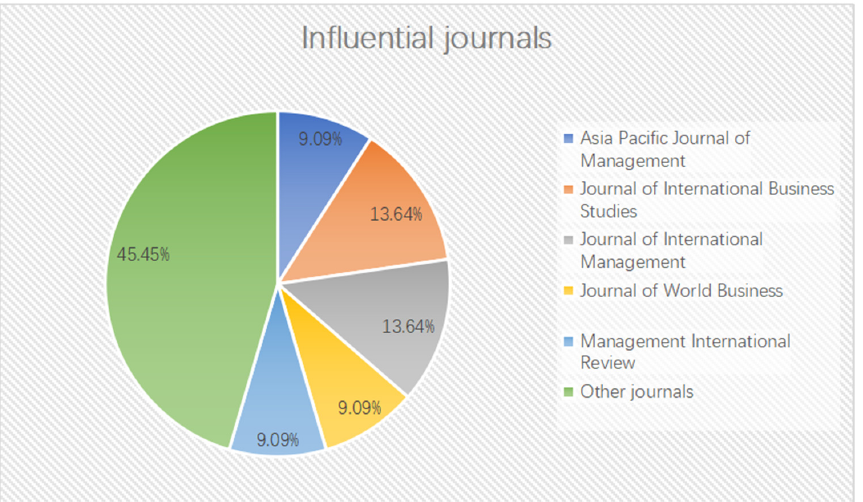
Figure 2. Influential scholarly journals on publishing articles on EMNE’s entry mode decision-making involving volatile environmental factors.